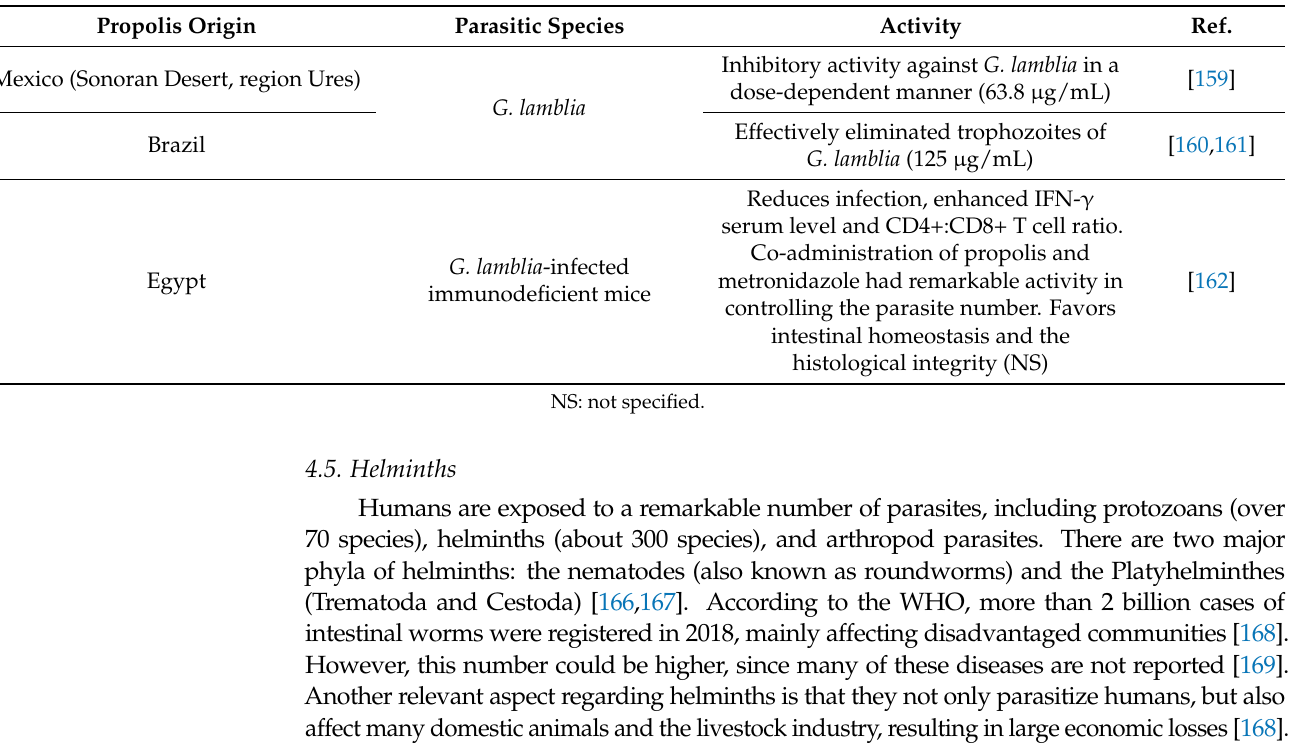
Table 15. Effect of different propolis on G. lamblia in in vitro and in vivo